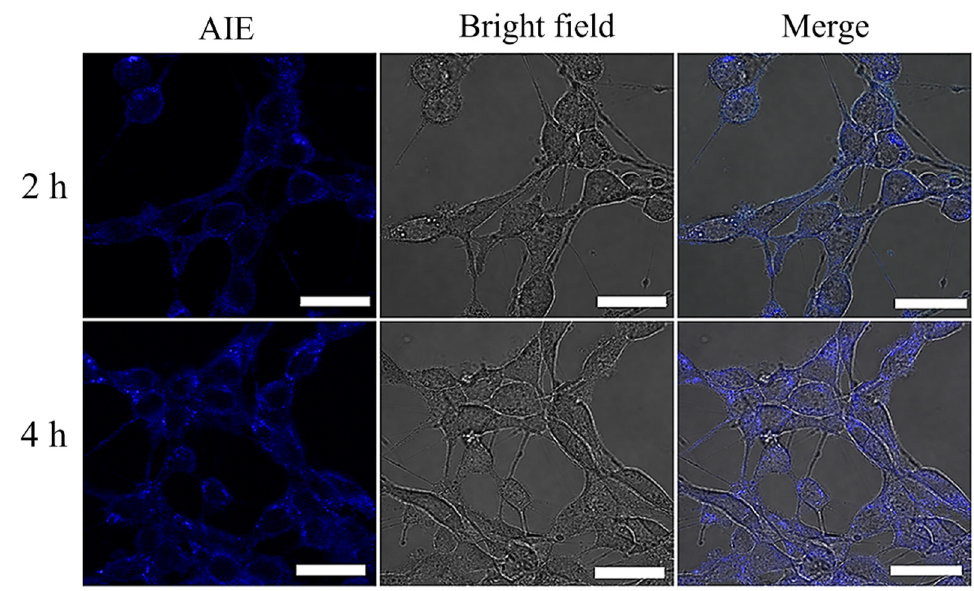
Figure 16. Photograph demonstrating the confocal fluorescence images captured after incubation of 4T1 cells with m-PEG-P(TPE- co -AEMA) probe for 2 to 4 h. Reprinted from reference [92] with the permission of the American Chemical Society.